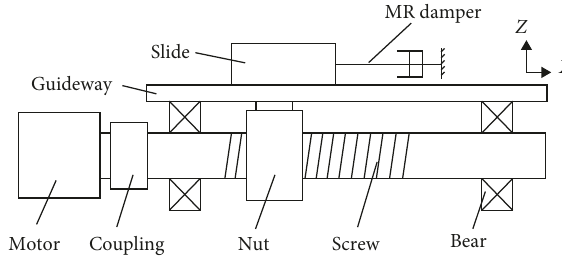
Figure 3: Structure of the hydrostatic slide system.